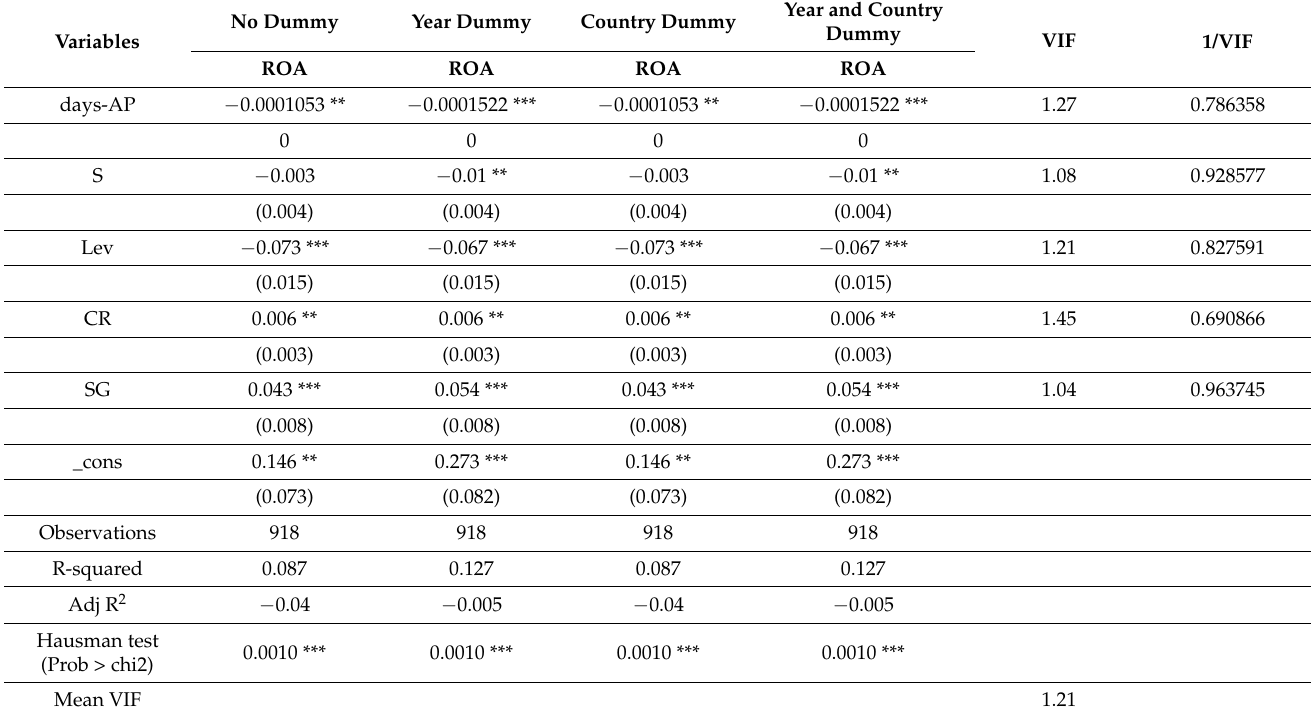
Table 10. Results of the fixed effects of days-AP on ROA, as per panel data regression (pre-pandemic period,